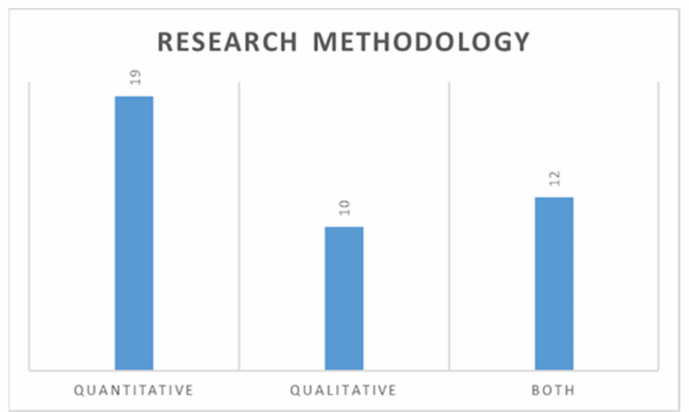
Figure 5. Nature-wise distribution of articles.